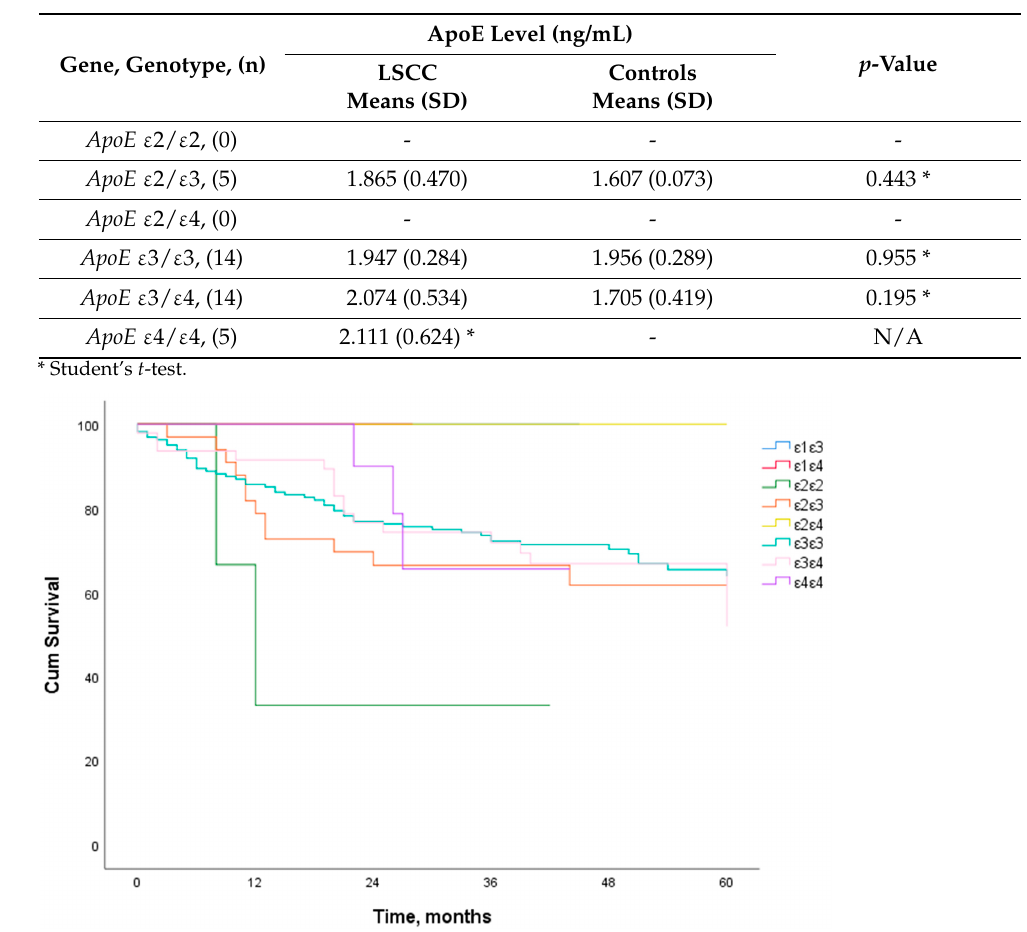
Figure 2. Five-year specific disease survival analysis of LSCC patients according to ApoE genotypes